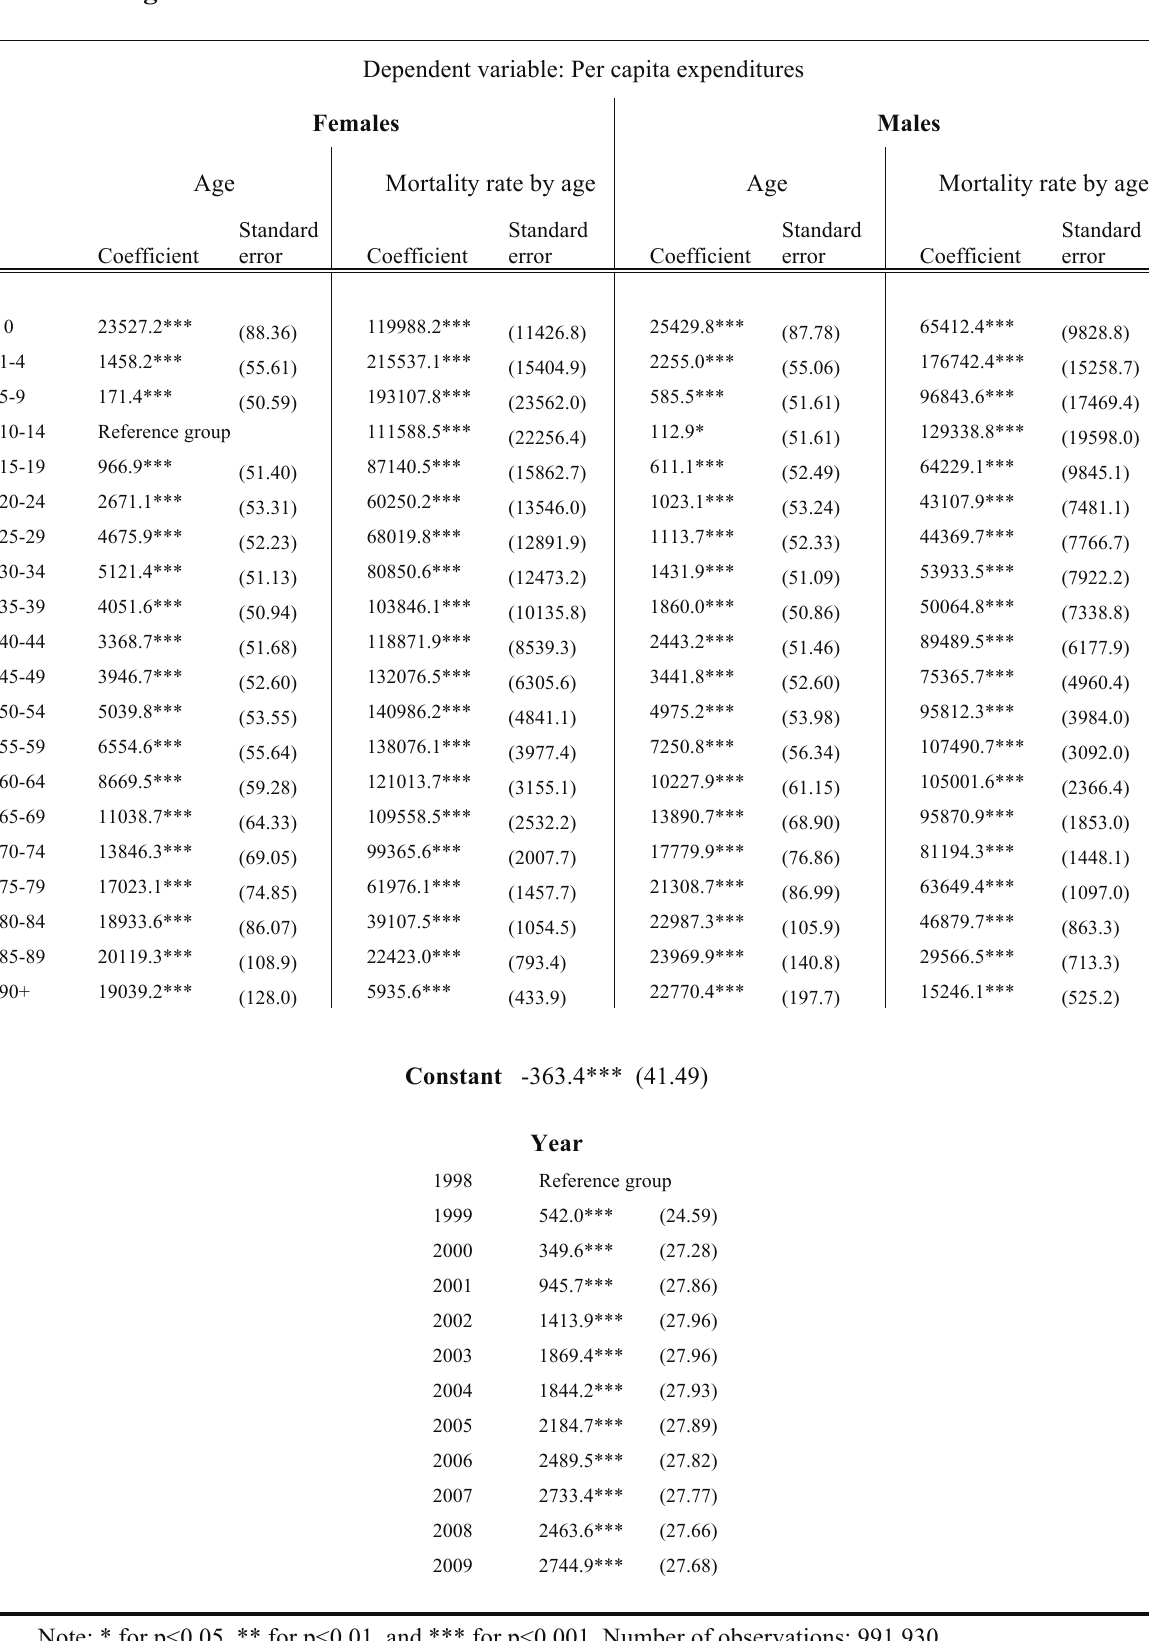
Table 3a: Results from weighted regression analysis of hospital expenditures assuming serial correlation in error